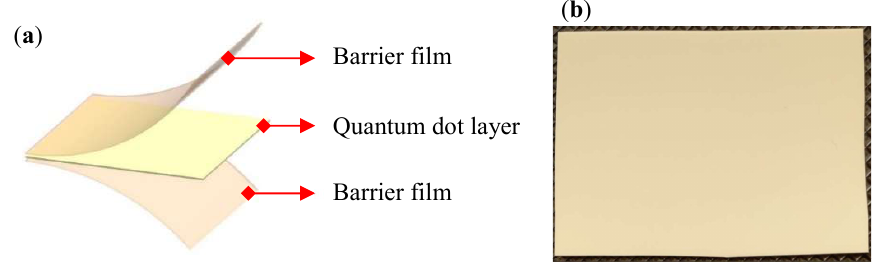
Figure 5. CdSe quantum-dot film: ( a ) schematic structure; ( b ) prototype.